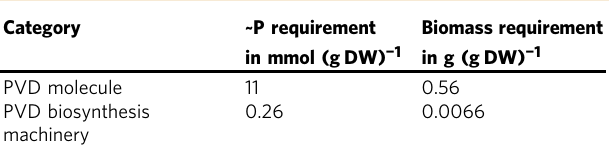
Table 1 Estimated energetic and biomass requirements